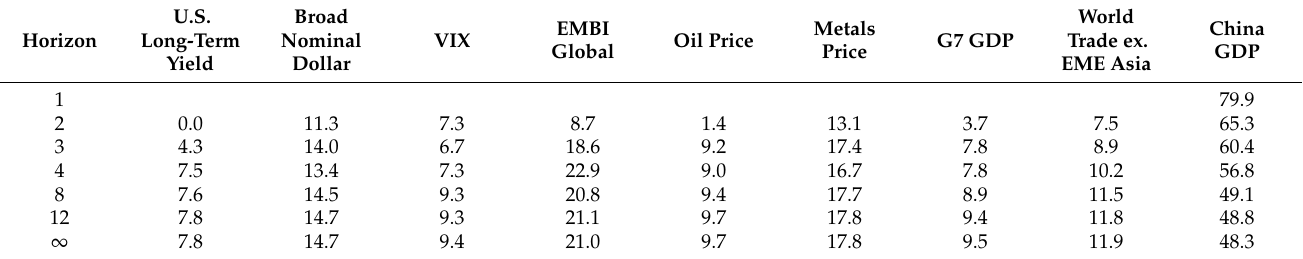
Table 6. Percent of forecast error attributable to China GDP by number of quarters.